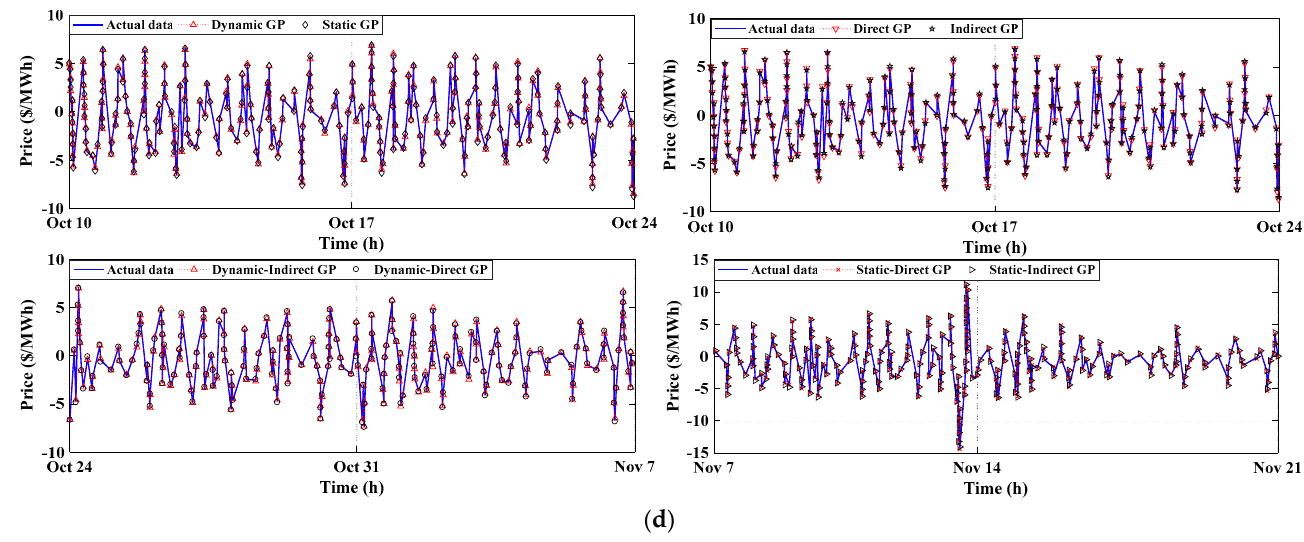
Figure 6. The forecasting of the sum of harmonic components of training data of EP using various models for the electricity market of Spain: ( a ) winter, ( b ) spring, ( c ) summer, ( d ) autumn.